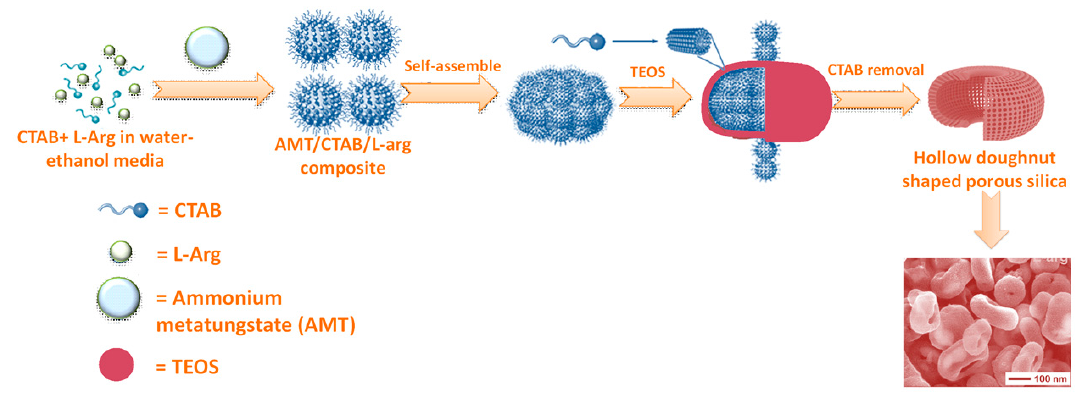
Figure 9. A simple scheme for synthesis of doughnut shaped mesoporous silica hollow sphere.